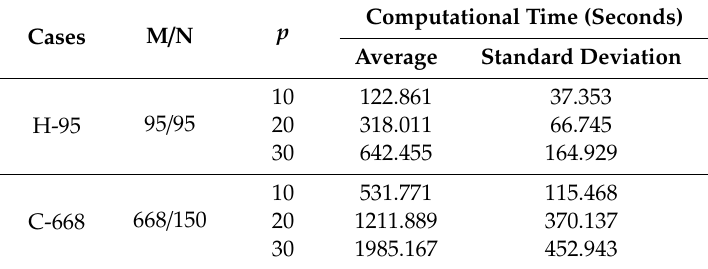
Table 1. The computational time of 51 runs for all 100-scenario instances.